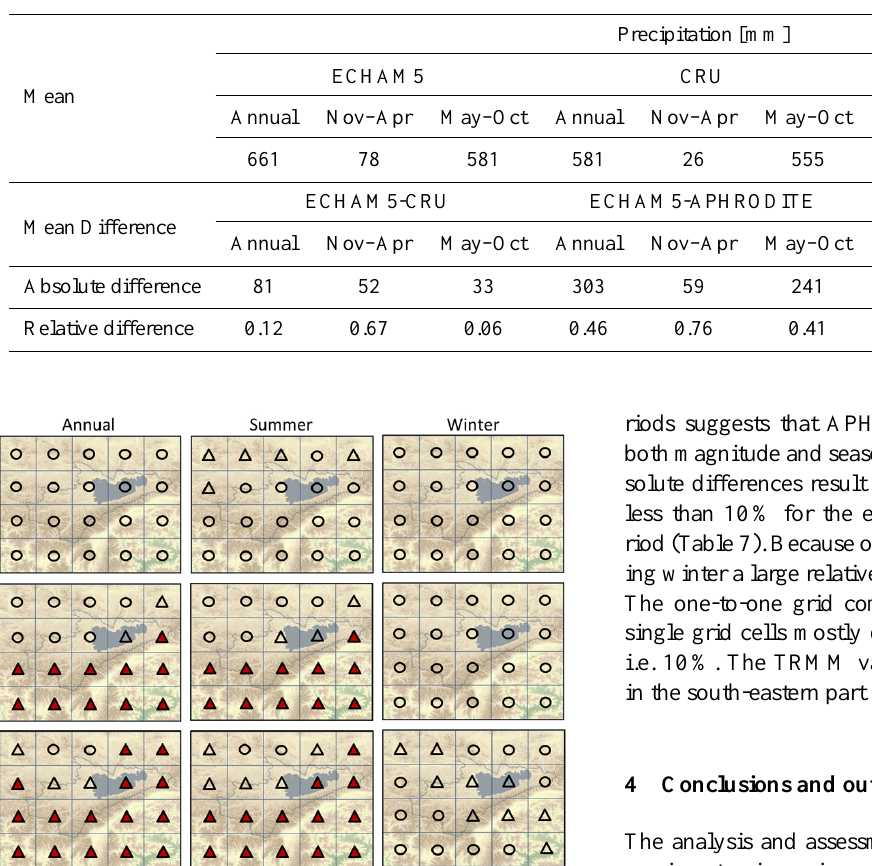
Table 6. Statistical analysis results for precipitation data of ECHAM5, CRU and APHRODITE for the period 1981–2004.